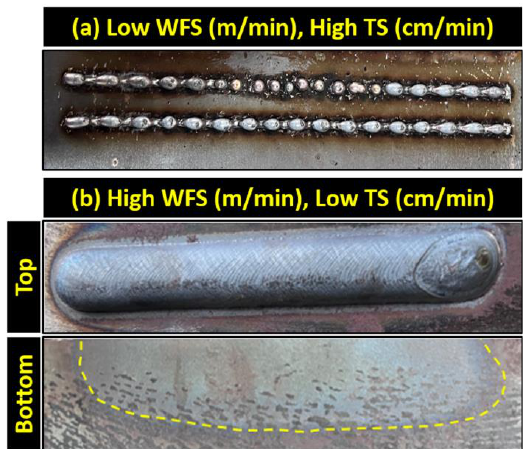
Figure 3. The defects include ( a ) humping and ( b ) high heat input, observed during the selection of the range of parameters for optimization using the RSM approach. Table 2. Three levels of process parameters, applied to optimize a single bead using the RSM ap- proach in the WAAM process.